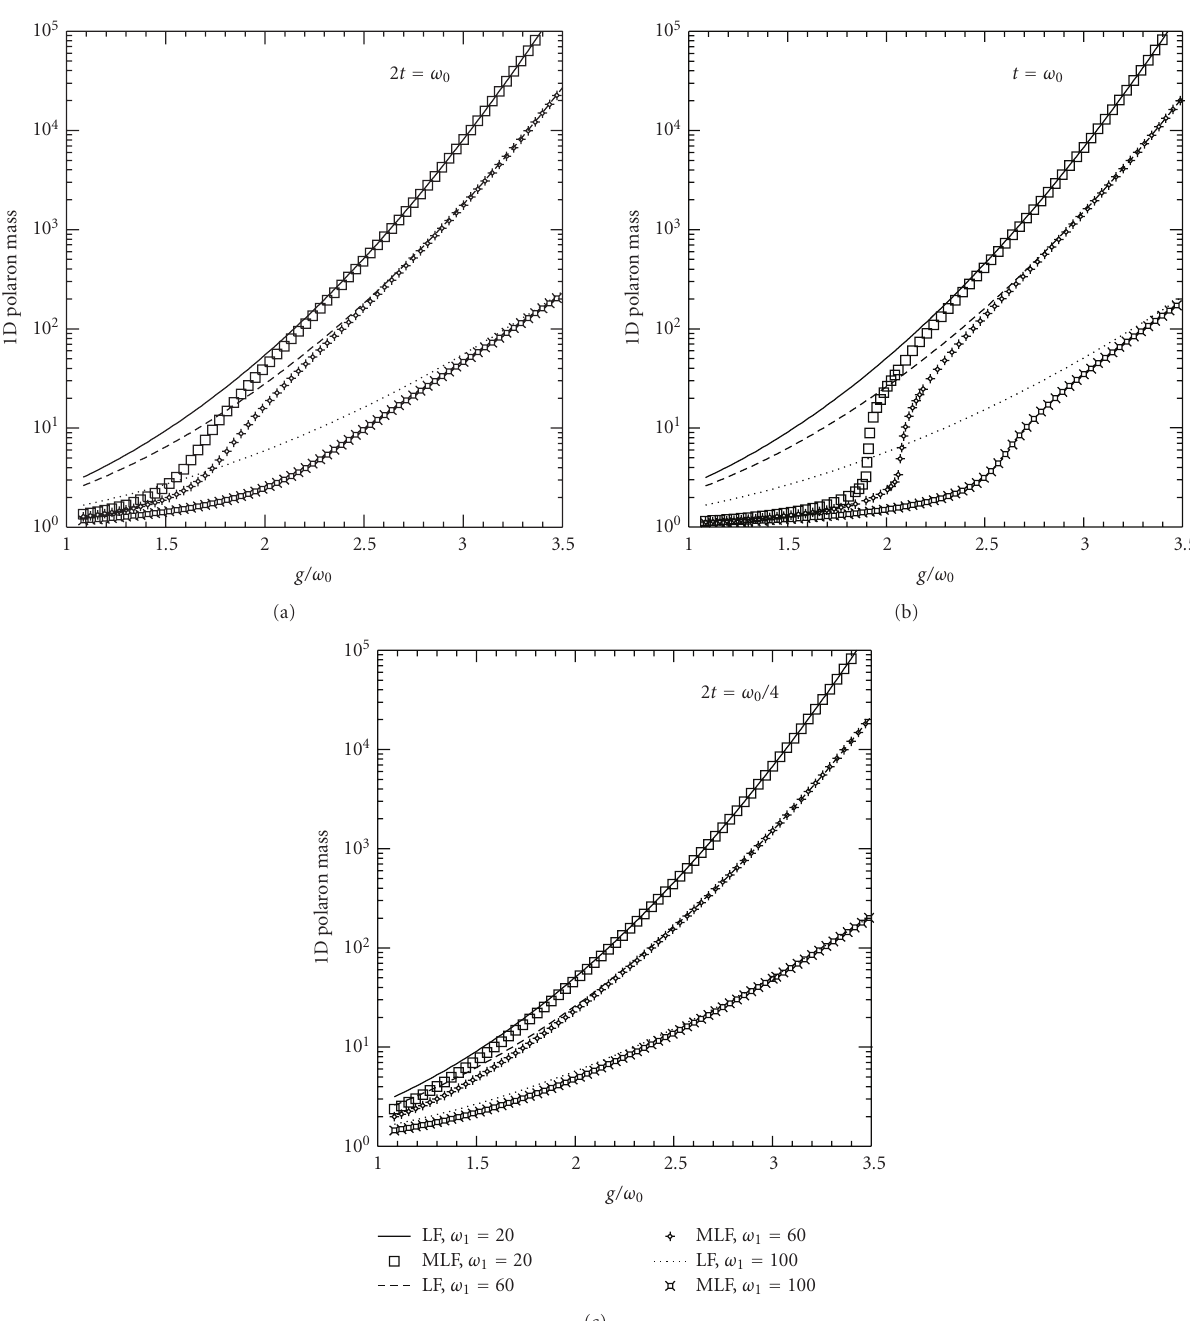
Figure 1: Ratio of the one-dimensional polaron mass to the bare band mass versus e-ph coupling according to the Lang-Firsov and the Modified Lang-Firsov methods. The adiabatic parameter is set at (a) the intermediate value, 2 t/ω 0 = 1; (b) a fully adiabatic regime, 2 t/ω 0 = 2; and (c) an antiadiabatic regime, 2 t/ω 0 = 0 . 25. ω 0 = 100 meV and ω 1 (in units meV) are the intramolecular and intermolecular energies of the diatomic molecular chain,